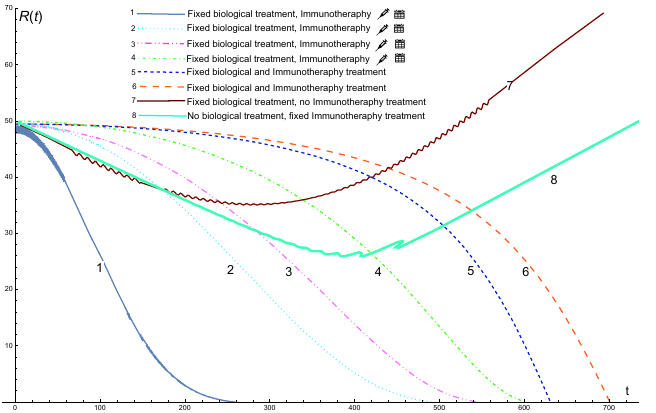
Figure 7. Solution profiles of the mathematical model for different combinations of treatment, that is, biological and immunotheraphy treatments. The injector drawing indicates varying doses, and the calendar drawing indicates that the times